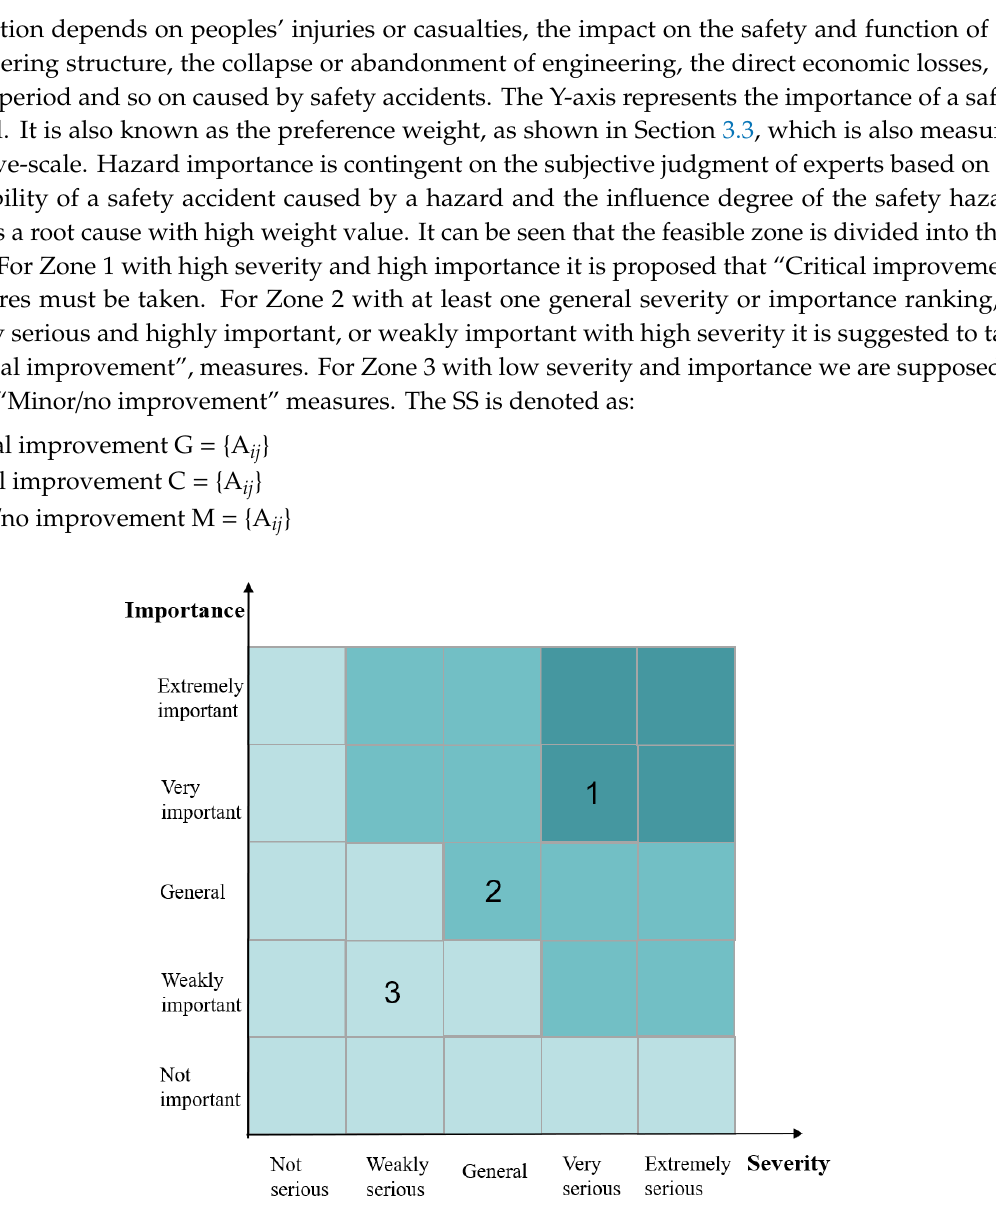
Figure 2. Evaluation principle of improvement strategies.